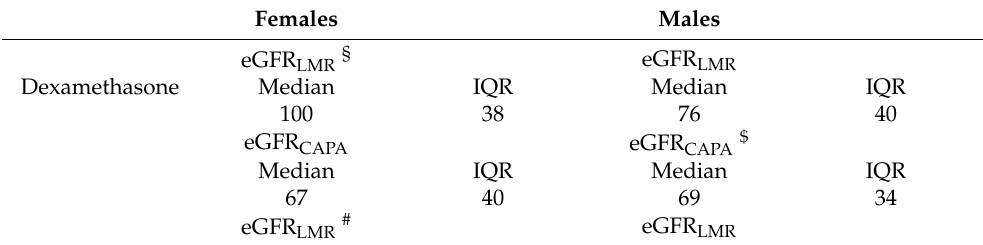
Figure 1. eGFR CAPA was lower in dexamethasone-treated patients, whereas eGFR LMR was lower in men. Age (years) and maximal CRP (mg × L –1 ) were associated with declining eGFR irrespective of equation, whereas increasing body mass index (BMI; weight (kg) × height (m) –2 ) correlated to higher eGFRs. Table 3. Pattern of ICU-treated COVID-19 patients based on absolute eGFR (mL/min), with respect to gender and dexamethasone treatment; females vs.